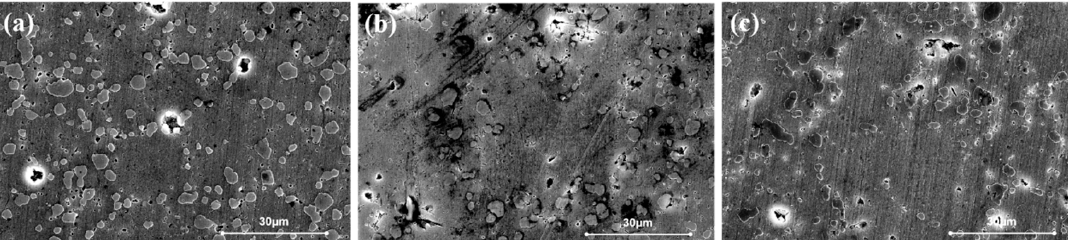
Figure 3. Immersion corrosion rates of ( a ) Al-7%Si-0.3%Mg-0.3%Cr alloy and ( b ) Al-7%Si-0.3%Mg- 0.3%Cr-1.5%Cu alloy alloys after di ff erent ageing time.